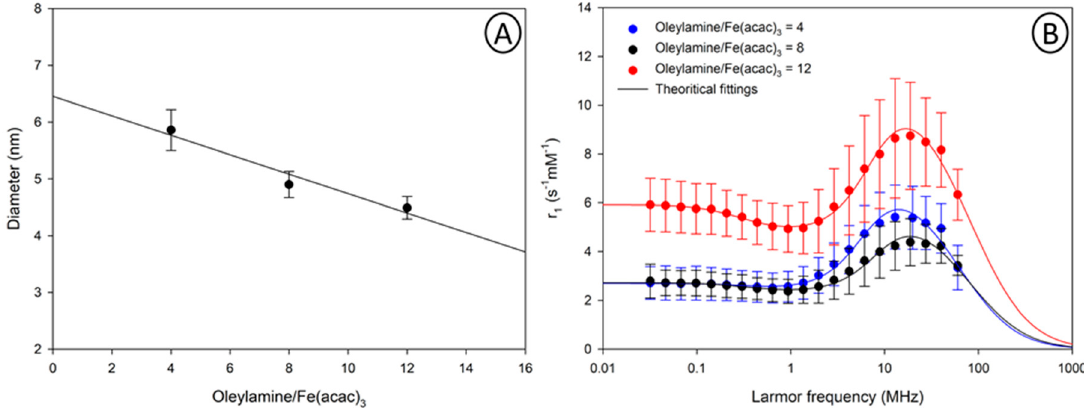
Figure 3. ( A )Evolution of TEM diameter as a function of the oleylamine amount; ( B ) 1 H NMRD profiles of samples obtained by flow synthesis with various amount of oleylamine.